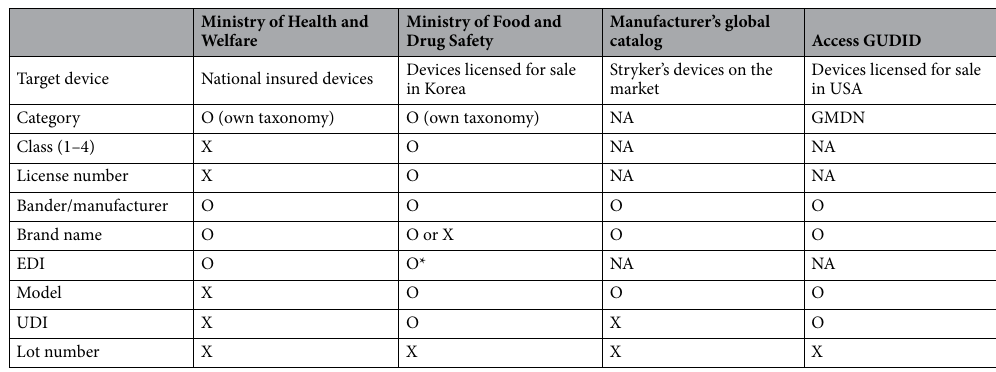
Table 2. Various medical device data acquired from multiple sources. GUDID global unique device identification database, GMDN global medical device nomenclature, NA not available, EDI electronic data interchange, UDI unique device identifier. * In case of insurance